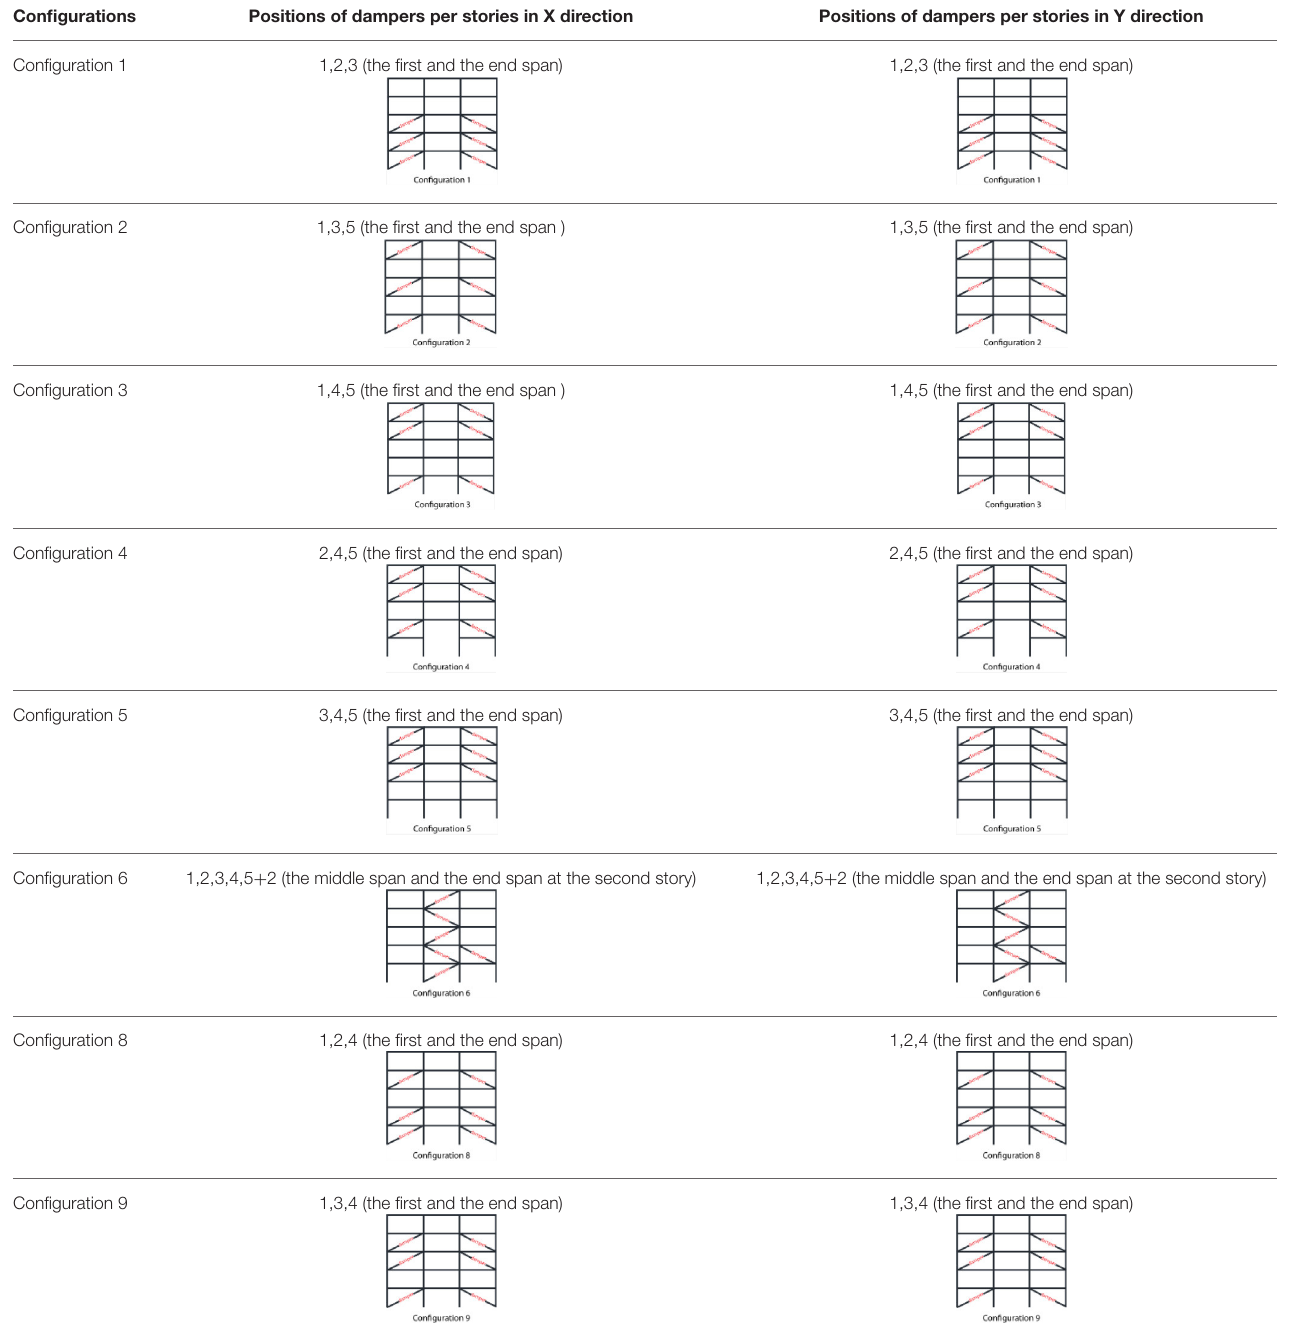
TABLE 1 | Initial configurations of